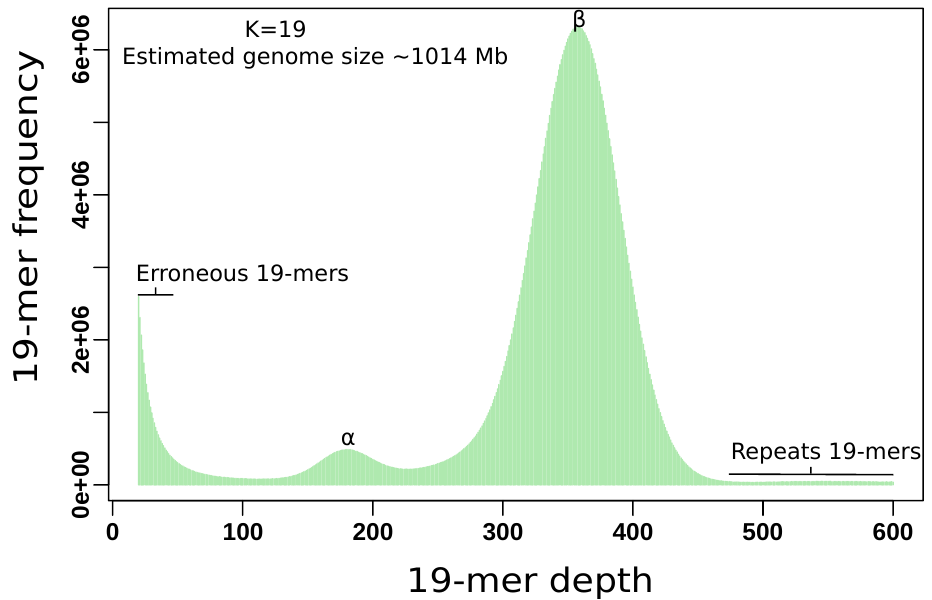
Figure 1. Estimated characteristics of Sander lucioperca genome based on 19-mer analysis. The vertical axis represents the 19-mer depth, and the horizontal their corresponding frequency. α is the heterozygous and β the homozygous peak. Low coverage (<50) 19-mers are putative erroneous sequences, whereas deep coverage (>450) 19-mer indicate repetitive genomic